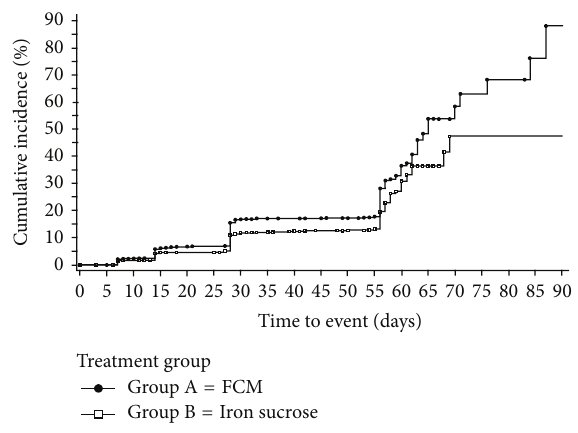
Figure 2: The time from randomization to first hemoglobin > 12g/dL in patients who received 1500 mg IV iron and patients who received 1000 mg from Study 7, 𝑝 < 0.001 . Day 56 is the last study visit, and at the discretion of the investigator, patients were allowed toberetreatedwithadditionalIVironbetweenDays56and90.Data on file, Luitpold Pharmaceuticals,